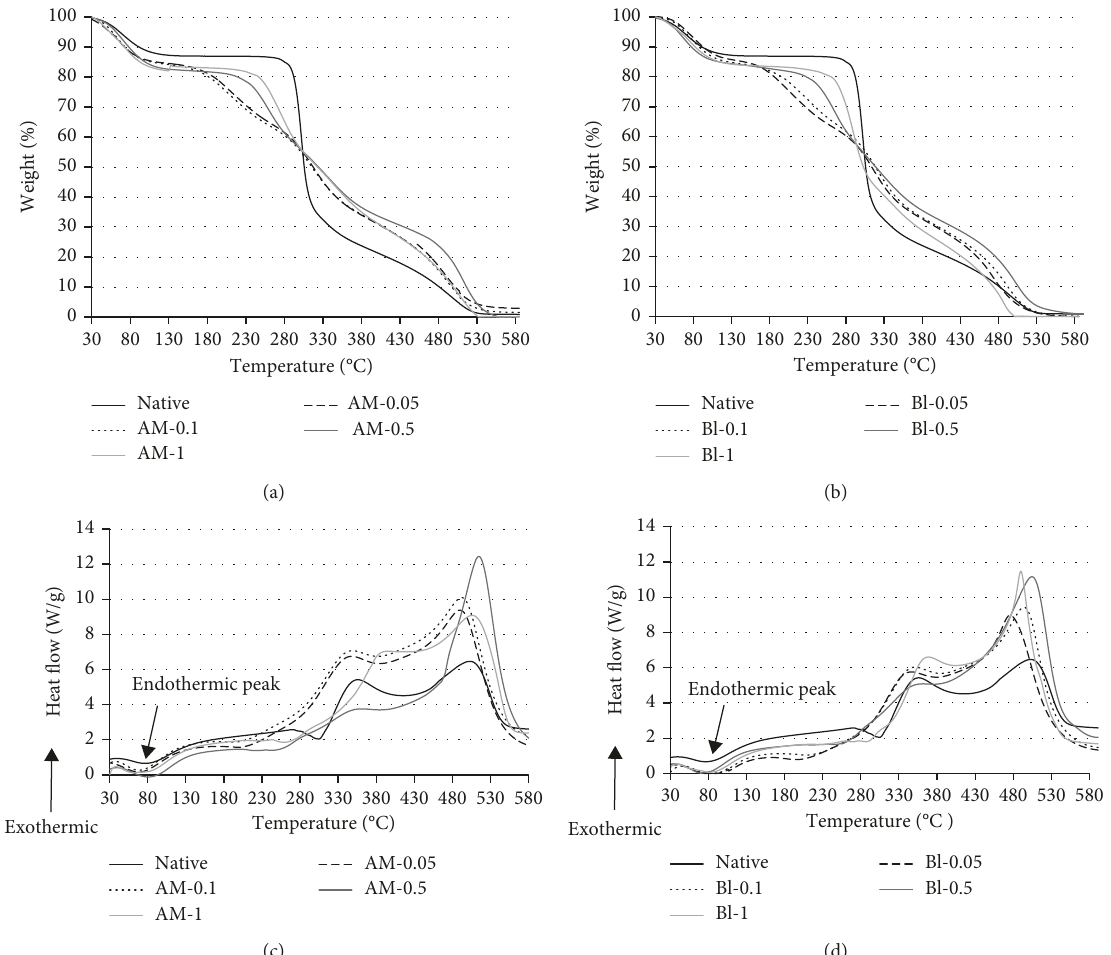
Figure 4: TGA (a, b) and DTA (c, d) curves of native and treated